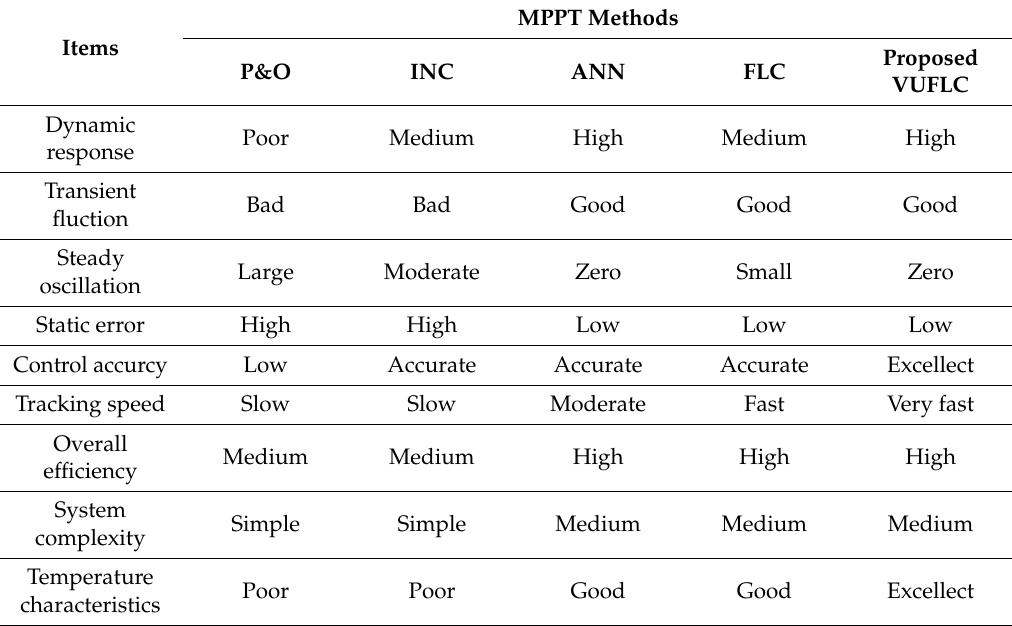
Table 4. Performance comparison of different MPPT control methods.